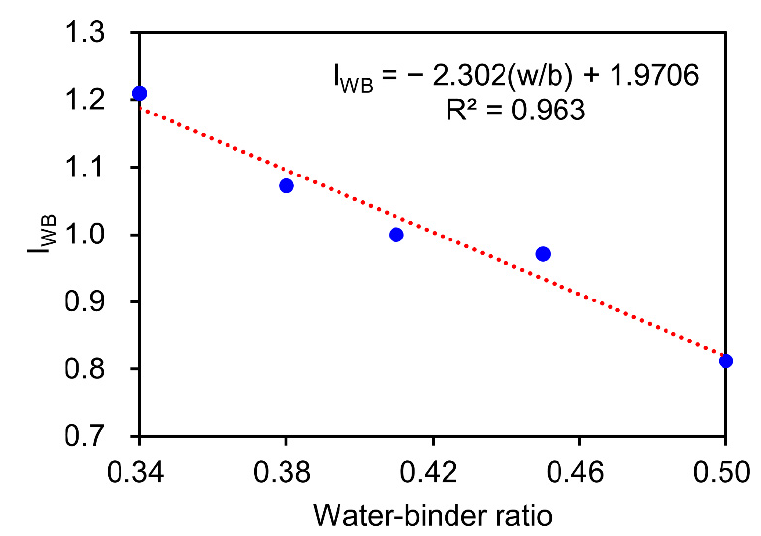
Figure 6. Effect of the w/b ratio on DRC of the concrete exposed to sulfate solution under DW cycles. The effect of the w/b ratio on DRC were fitted as follows: